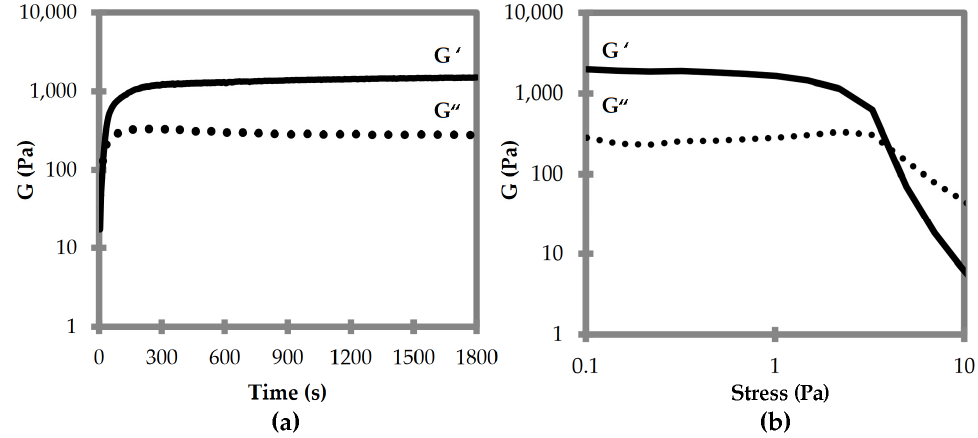
Figure 6. Oscillatory rheological analyses for DKP2 soybean gels. ( a ) Time sweep. ( b ) Frequency sweep. G’ is the elastic or storage modulus. G” is the viscous or loss modulus.